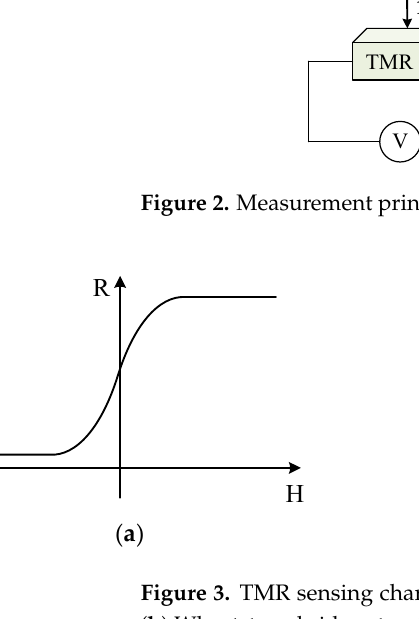
Figure 2. Measurement principle diagram of the TMR current sensor.